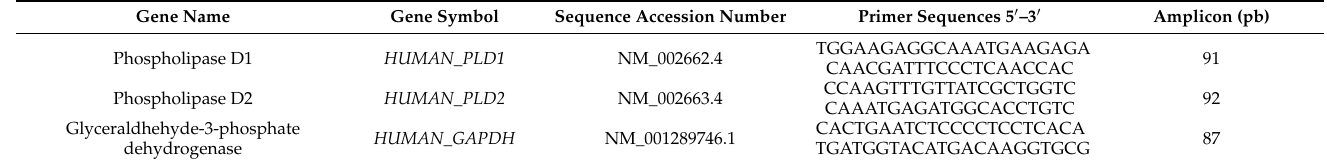
Table 1. Primer sequences for the specific amplification of human PLD1, PLD2 , and GAPDH